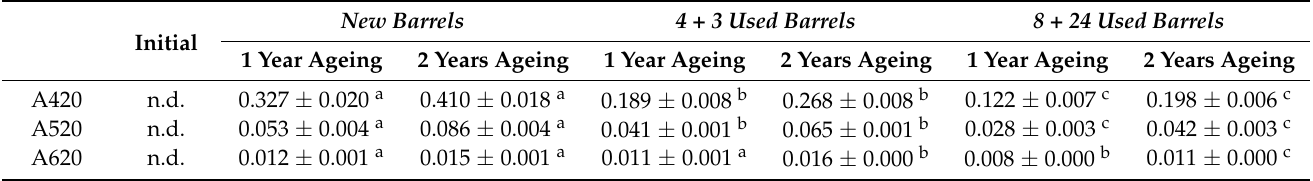
Table 6. Chromatic characteristics of the brandies studied after 1 and 2 years of